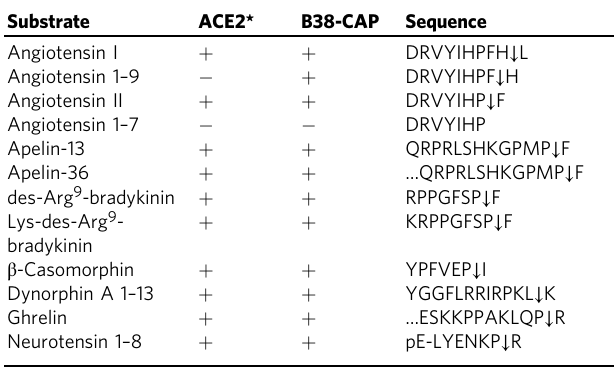
Table 2 Hydrolysis of ACE2-substrate peptides by